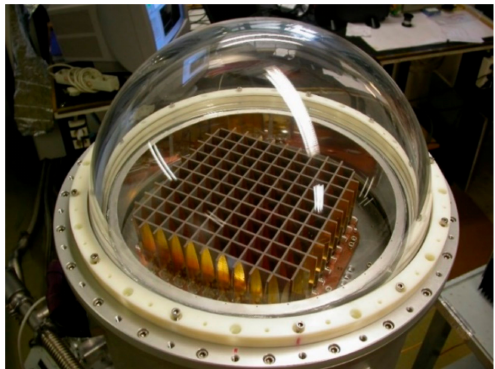
Figure1. Phasedarraysforreflectorobservingsystems2(PHAROS2)focalplanearrayanddome-shaped vacuum window (15.6 mm thick plexiglass) attached to the cryostat (external flange diameter of 455